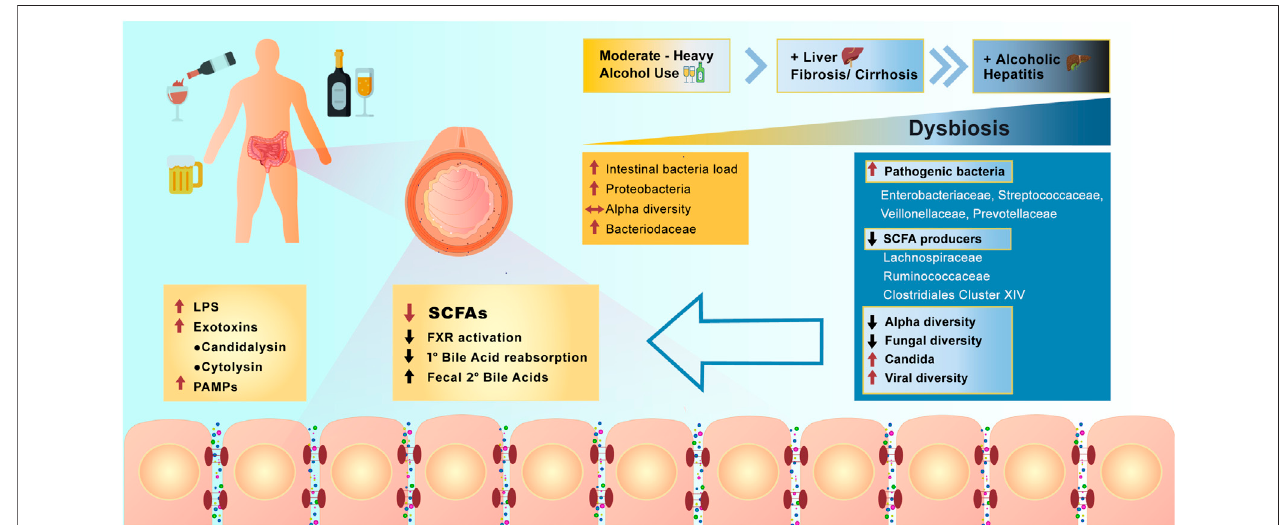
FIGURE 4 | Effect of alcohol overconsumption on the gut microbiome and intestinal homeostasis. Over consumption of alcohol positively correlates with the severityofmanifesteddysbiosisin thelower boweland occurrenceliver diseases. Dysbiosis resulted from alcohol overconsumption, leadstotheincrease inabundance of pathogenic bacteria, increase in viral diversity, production of LPS, secondary bile acids and activation of farnesoid X receptor (FXR). Alcohol overconsumption also downregulates production of SCFAs, results in decreased alpha and fungal diversity and decrease reabsorption of primary bile acids (PAMPs (cid:1) pathogen associated molecular